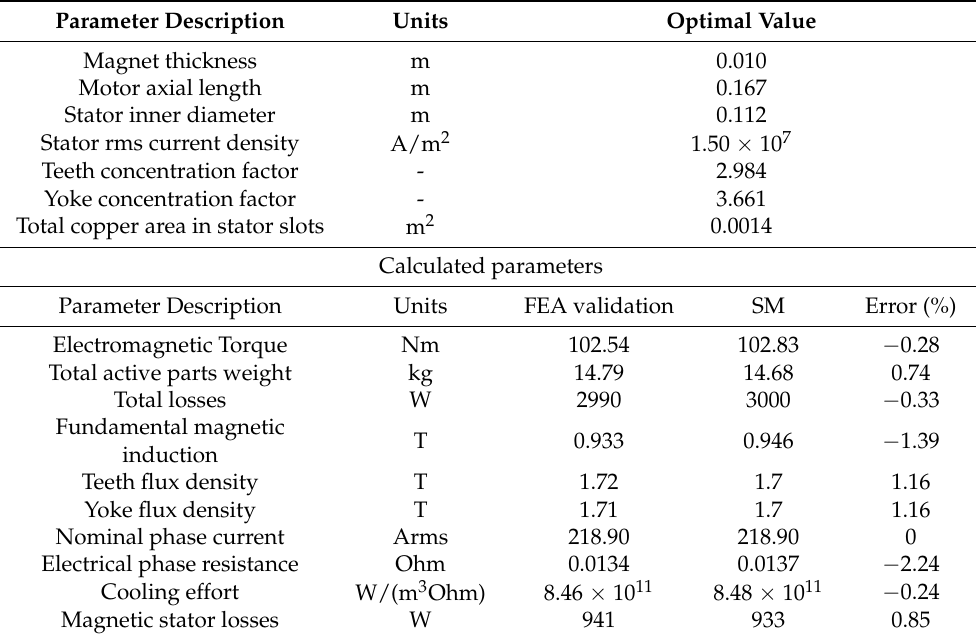
Table 9. Optimal results obtained by SM and